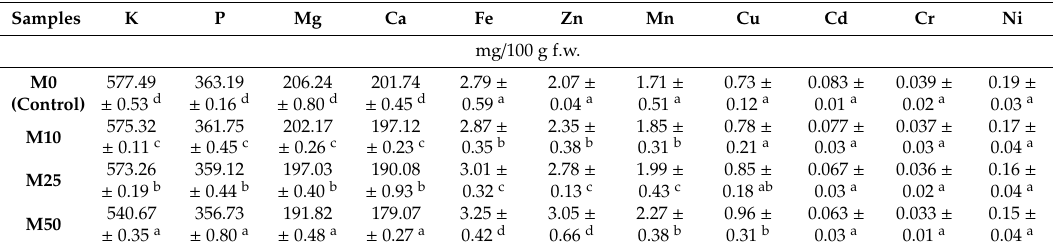
Table 4. Mineral content of modified macaron with walnut